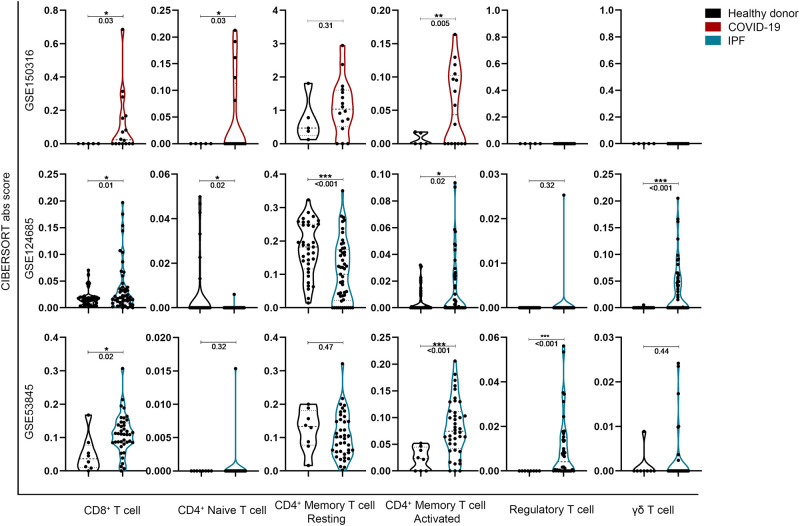
In silico simulated T-cell lineage infiltration in lung tissue between COVID-19 and IPF patients.*P<0.05, **P<0.01 and ***P<0.001, with comparisons indicated by brackets.